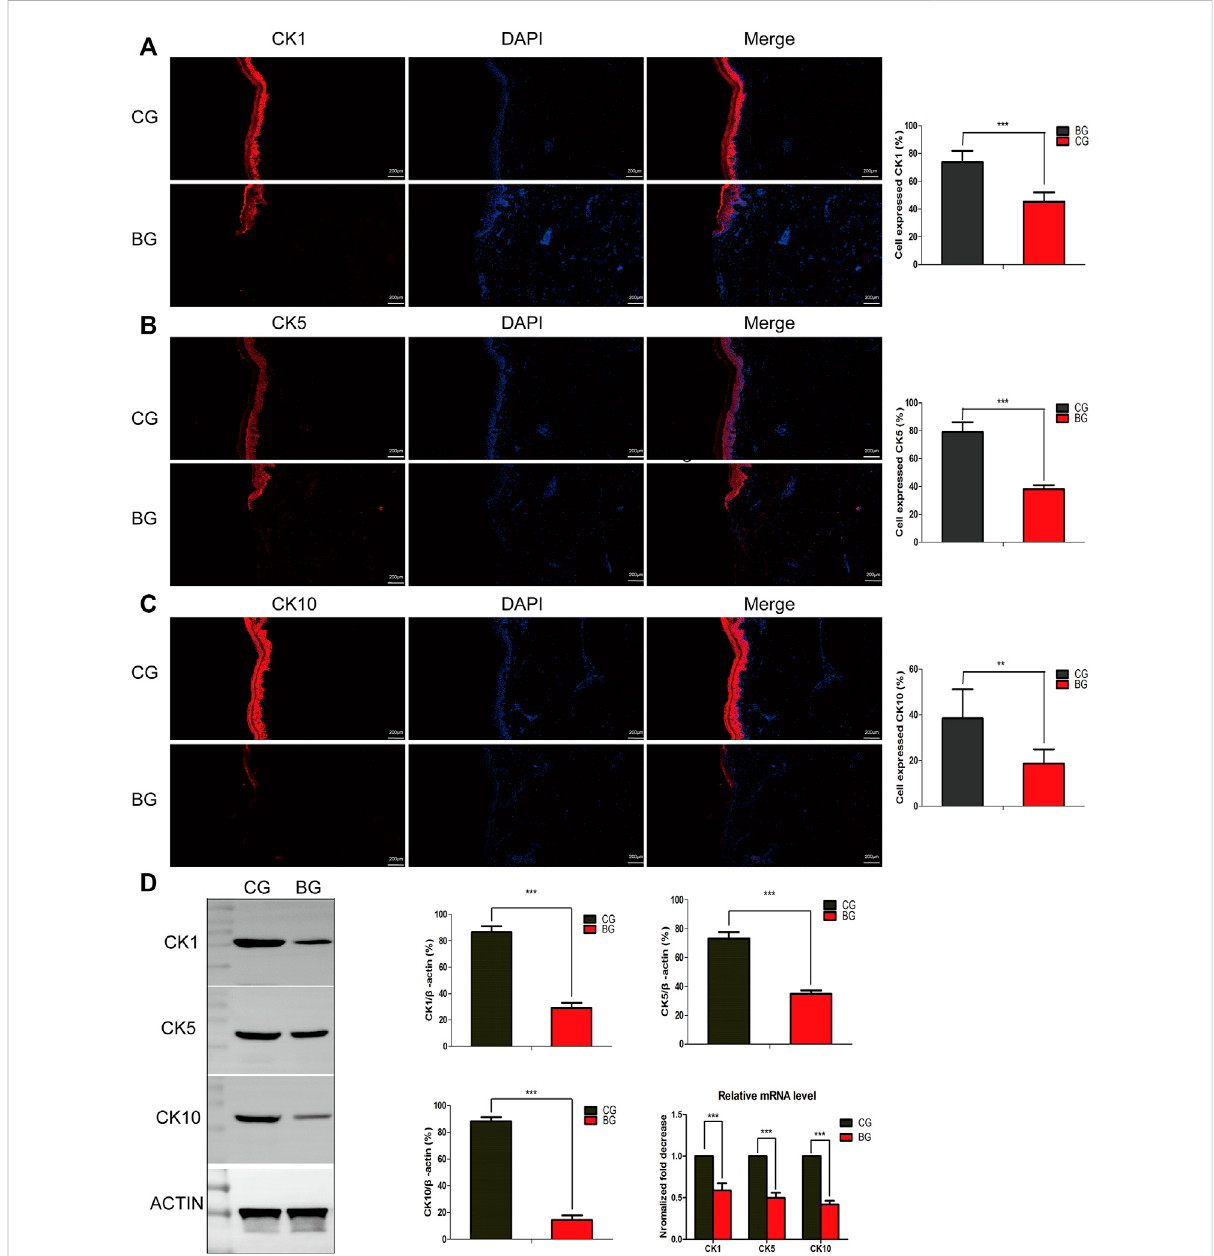
FIGURE 5 (A – C) Immuno fl uorescenceanalysisofnormalandblisteredskin.Imagesofimmuno fl uorescencestainingofthecytokeratinsK1,K5,andK10in the two groups. In accordance with the immunohistochemical results, the number of positively expressing cells was compared for K1, K5, and K10, andthepositiveexpressionratewassigni fi cantly decreasedintheBG. (D) RepresentativeWesternblotsofcytokeratinsK1,K5,andK10incontroland blistered human skin. It was observed that the expression of the three cytokeratins was signi fi cantly decreased in the BG group. *: p < 0.05, **: p < 0.01, and ***: p <